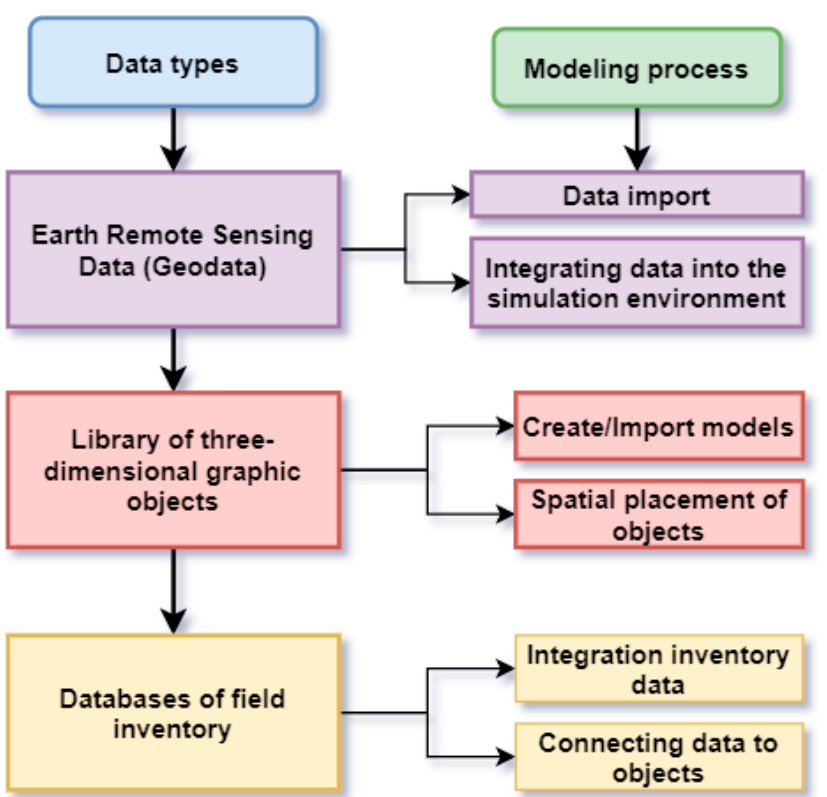
Figure 7. Main components of the digital forest model creation process.